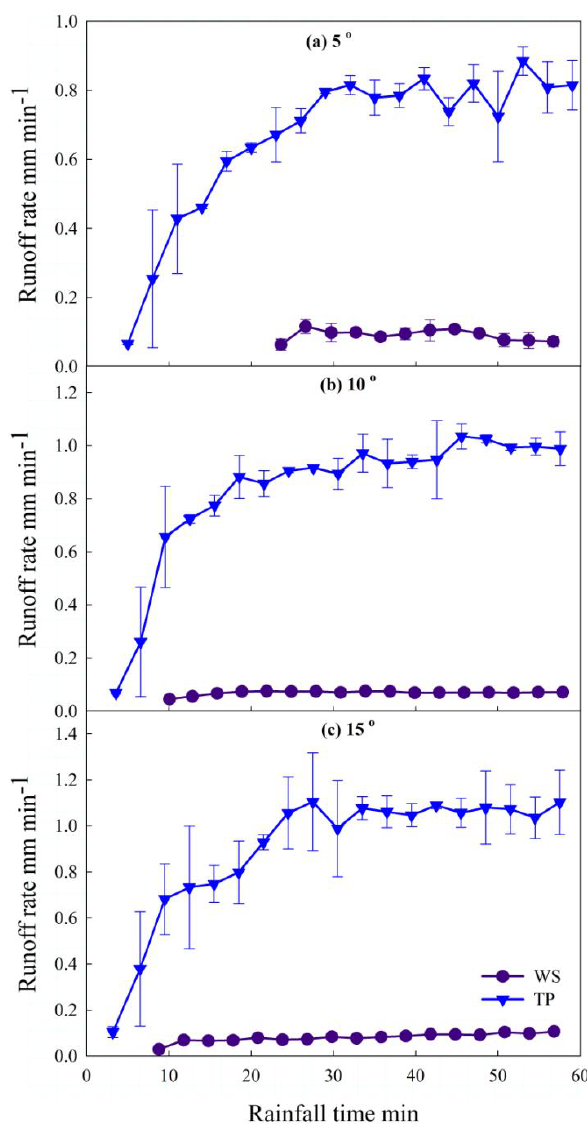
Figure 2. Dynamics of the runoff rate in WS and TP plot during the simulated rainfall